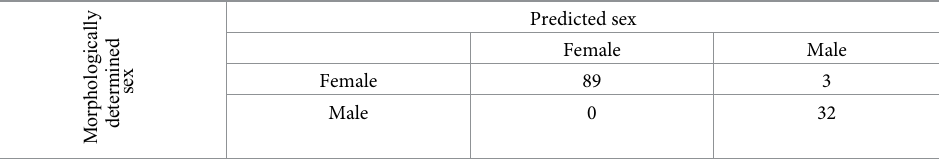
Table 2. Test set confusion matrix for sex prediction of mosquitoes based on ddRAD-seq markers identified from a Torres Strait dataset but tested against sexed samples from other